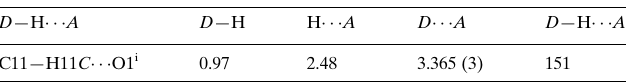
Hydrogen-bond geometry (A˚ , (cid:2)